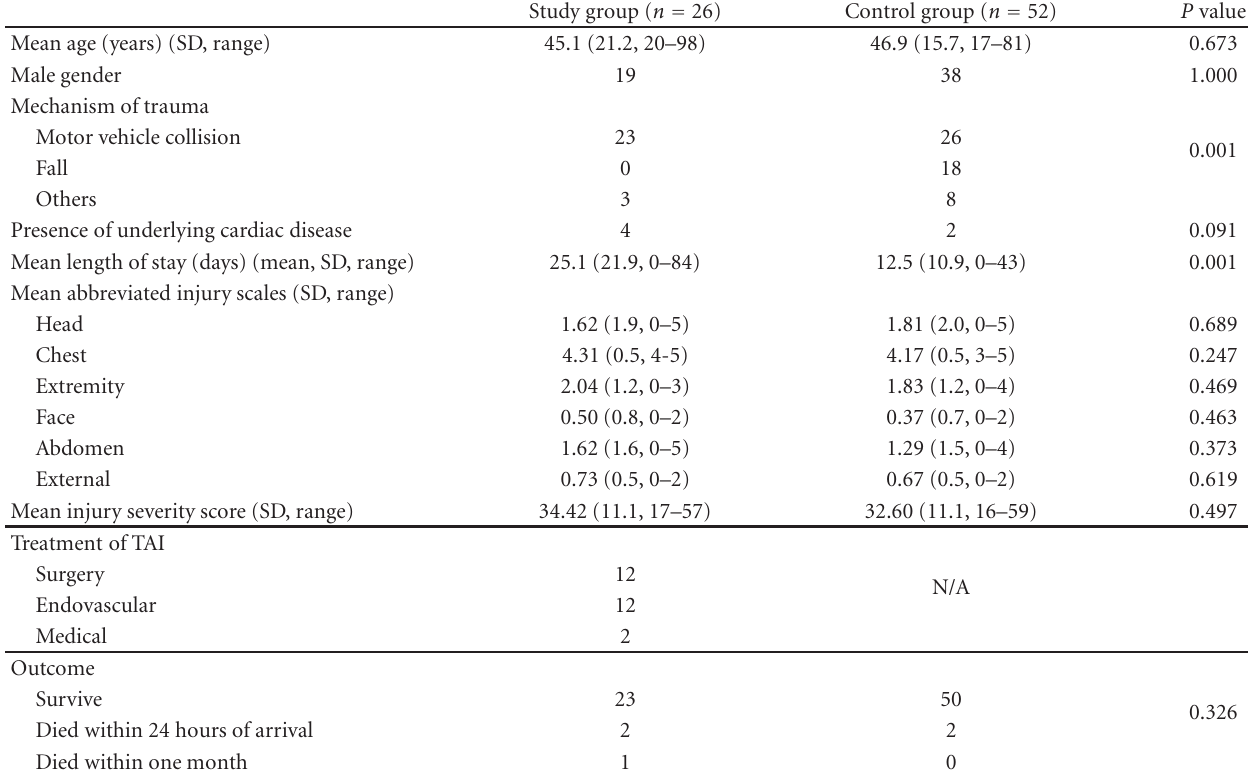
Table 2: Comparison between patients with TAI (study group) and without TAI (control group).